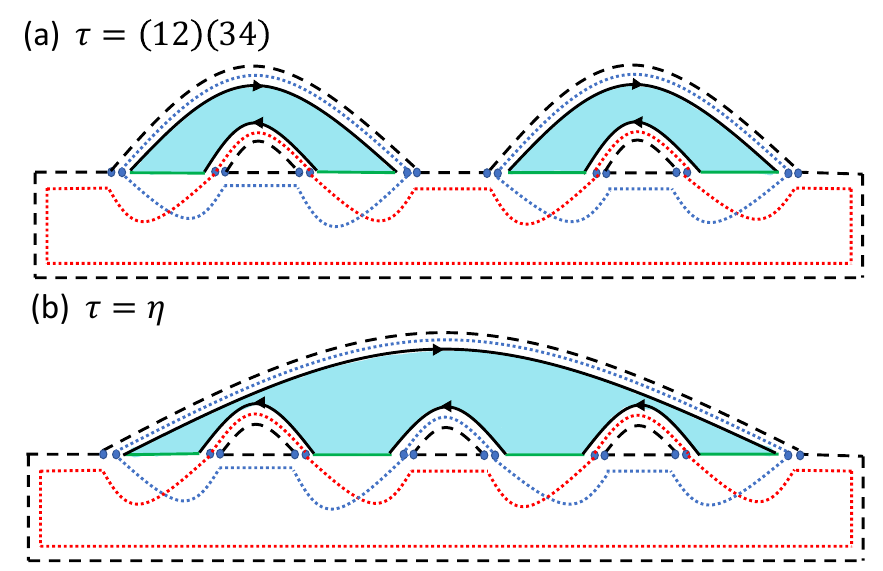
Figure 26 . Euclidean gravity path integrals with replica wormholes for calculating Z (PT) n in the model of [4], for n = 4 . The dominant contribution in the ES phase, shown in (a), involves connected partition functions Z between two asymptotic boundaries, while the ME phase contribution in 2 ,B (b) involves Z . The black lines with arrows are asymptotic boundaries in JT gravity (each with n,B length β , although the lengths appear to differ in the figure), and the green lines are EOW branes. The dashed and dotted loops simply give factors of d and d A 1 A 2